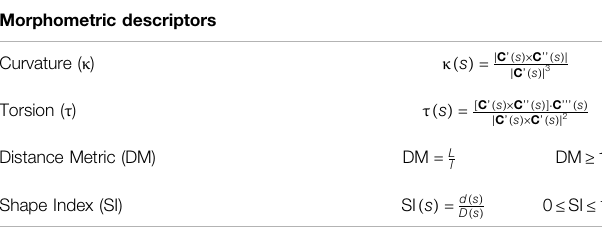
TABLE 3 | - De fi nition of the geometric quantities adopted for characterizing coronary vessels